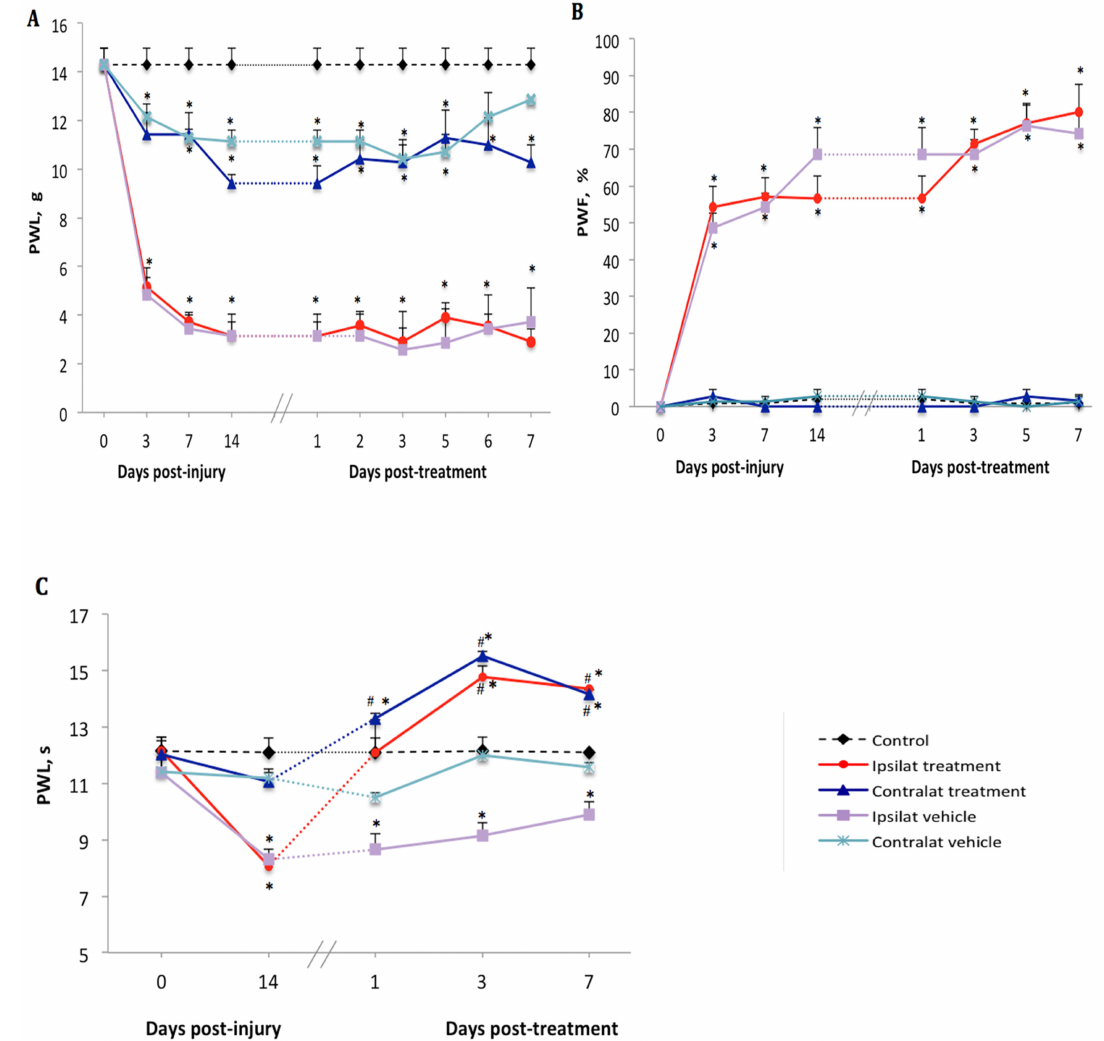
Figure 1. Nociceptive behavior after treatment with kinin B1 receptor (B1R) antagonist. E ff ect of one-week daily administration of SSR240612 (10 mg · kg − 1 , i.p.) and its vehicle on mechanical allodynia ( A ), cold allodynia ( B ) and heat-hyperalgesia ( C ). Post-treatment values from days 1 to 7 are the average of the e ff ect obtained during the first 2 h post-administration of the antagonist. Data represent the mean ± SEM of control ( n = 7), vehicle-treated ( n = 7) and SSR240612-treated ( n = 8) groups. At some points, SEM are not visible because they overlap with the points. Control values are from the ipsilateral sham-operated side of untreated rats. Statistical analysis indicates * p < 0.05 vs. control and # p < 0.05 vs. vehicle-treated group, (F = 4.66, p < 0.001), for all three types of hypersensitivity. 2.2. E ff ect of the B1R Antagonist on PSNL-Induced Nociceptive Behavior Beginning on day 14 post-PSNL, daily treatment for 7 days with the B1R antagonist SSR240612 − 1 (10 mg · kg , i.p.) did not reverse mechanical hypersensitivity in PSNL rats in both ipsilateral (2.9 ± 1.2 g) and contralateral (10.2 ± 1.8 g) paws when compared to vehicle values (3.7 ± 1.1 and PSNL-induced cold allodynia in both ipsilateral (80.0 ± 12.1%) and contralateral (0%) paws on day 7